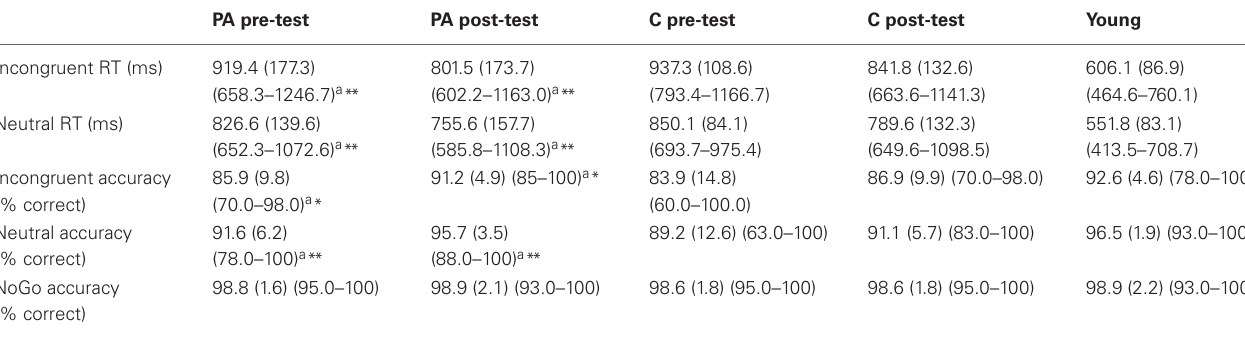
Table 2 | Mean task performance (SD) (range) for the physical activity (PA) and control (C) groups at pre-test and post-test, as well as the young adult group. PA pre-test PA